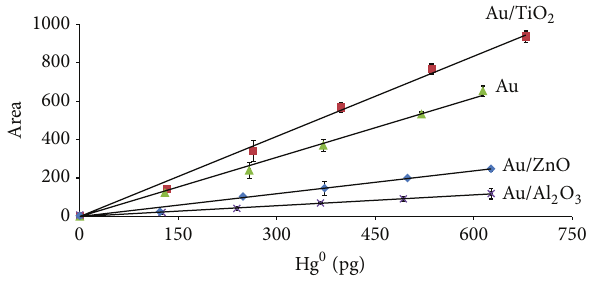
Figure 5: AFS calibrations of Hg 0 standards at argon flow of 60 mL min −1 .